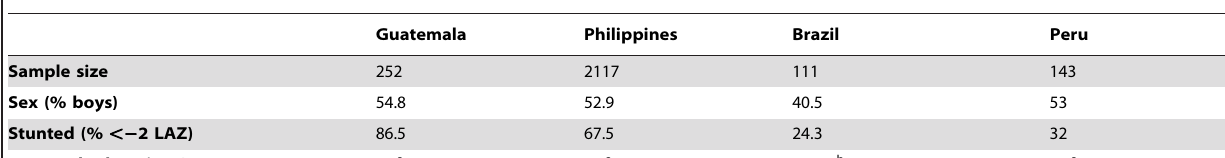
Table 1. Description of key study variables and variation in cognitive testing strategies across studies.